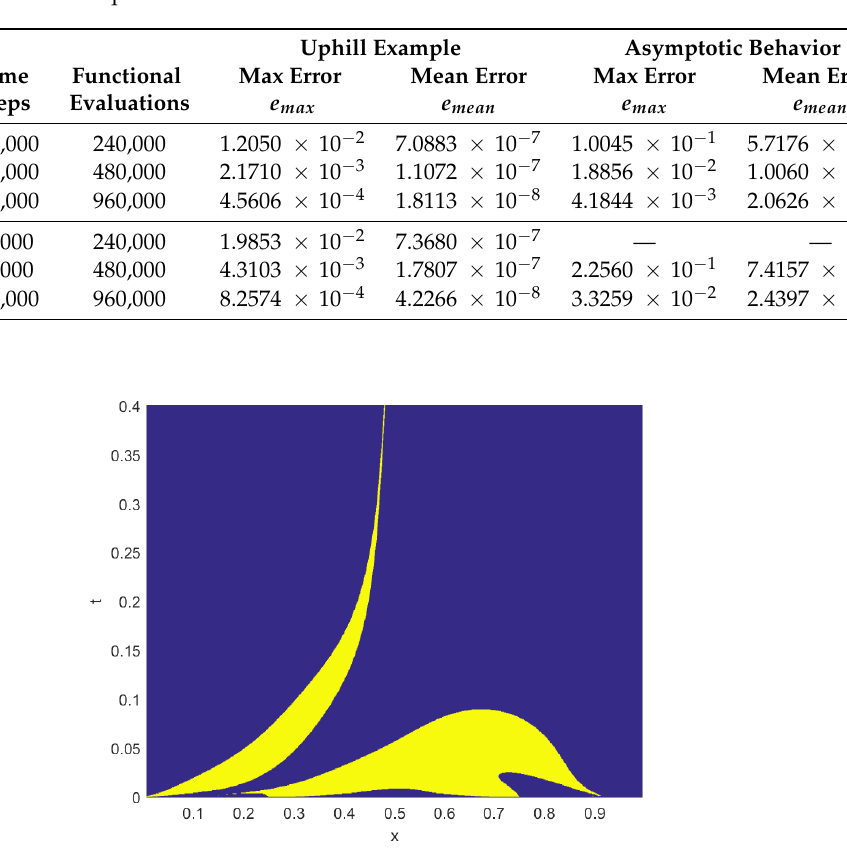
Figure 4. Evolution of the magnitudes u 1 and u 2 in the uphill example. Table 12. Cost and error estimates of the Heun integration (HI) and the Strang–Marchuk (SM) splitting for the nonlinear diffusion equation.